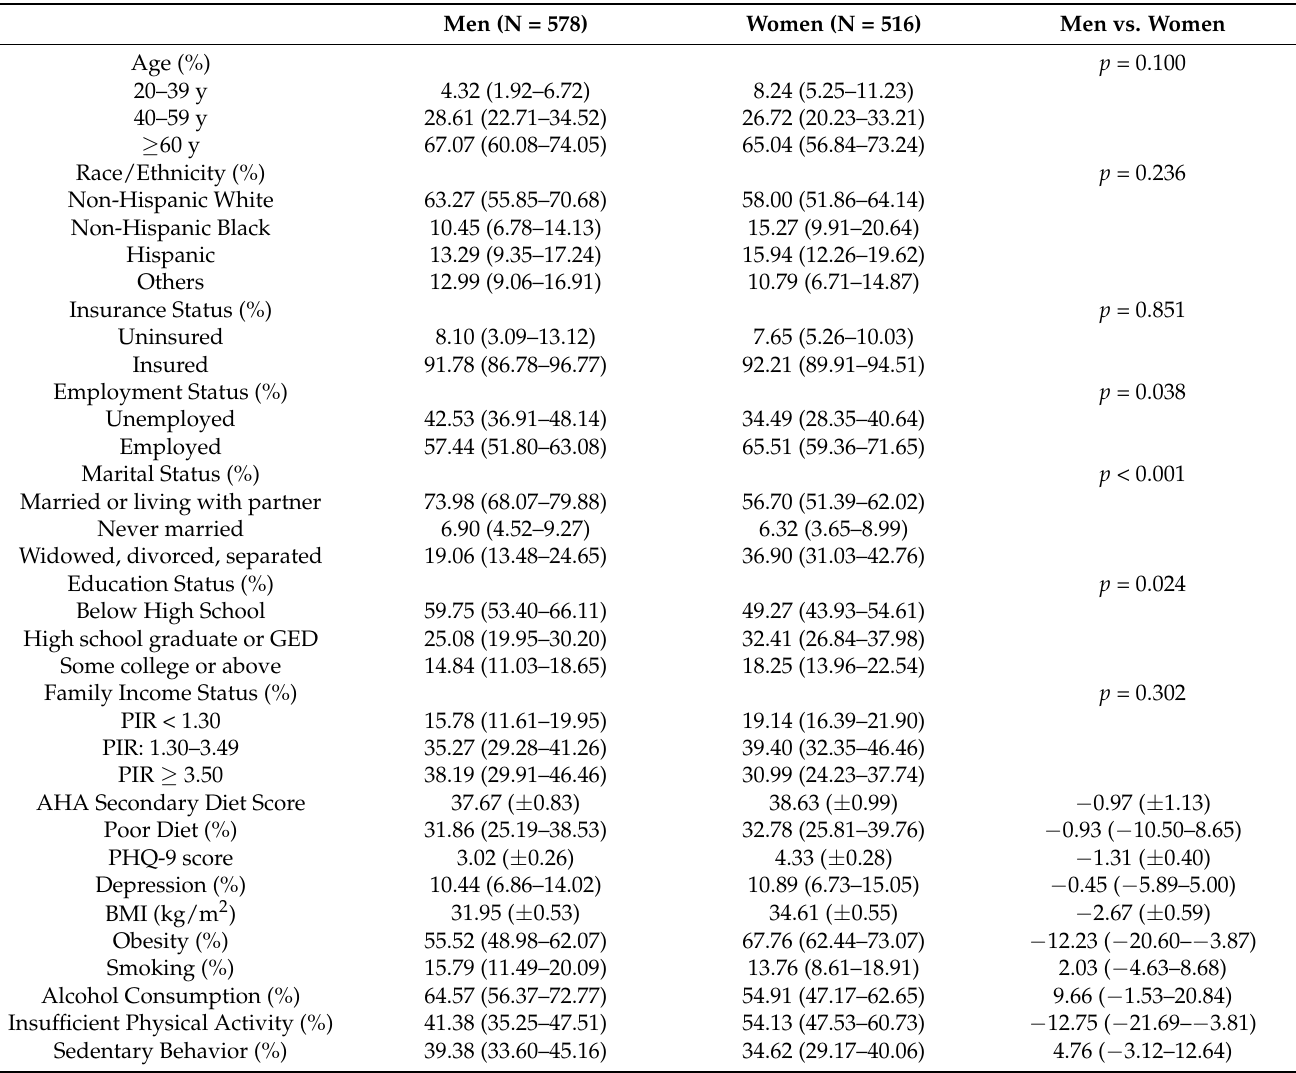
Table 1. Characteristics of participants with diabetes in the 2017~2018 NHANES survey. Men (N = 578) Women (N = 516) Men vs.